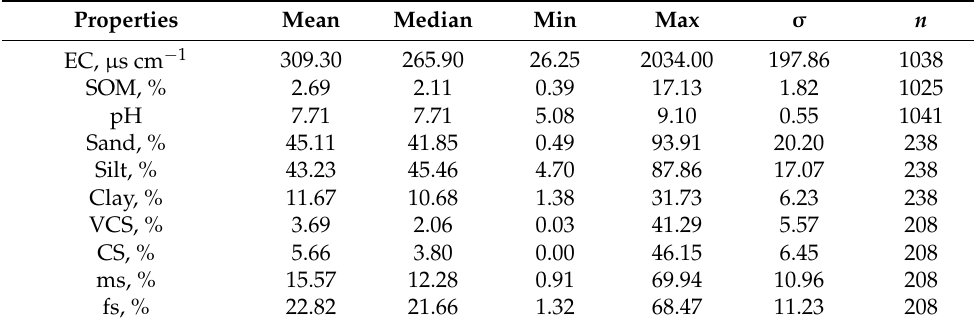
Table 5. Descriptive statistics for laboratory measured soil properties.